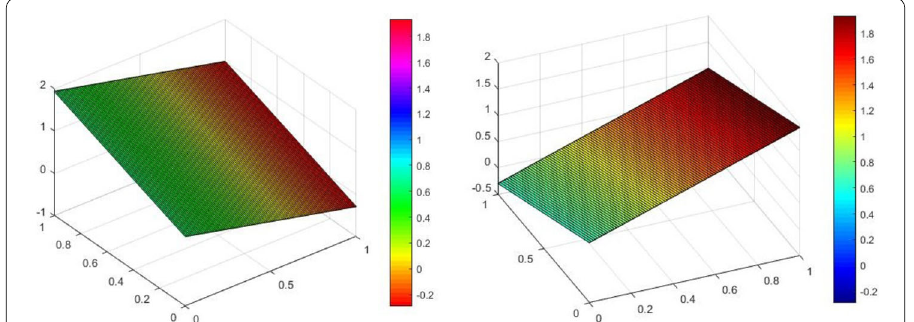
Figure 13 The ( a ) graph of exact and approximate solution of (cid:11) ( χ , ϕ , η ) ( b ) (cid:13) ( χ , ϕ , η ) at ϒ = 1 of Example